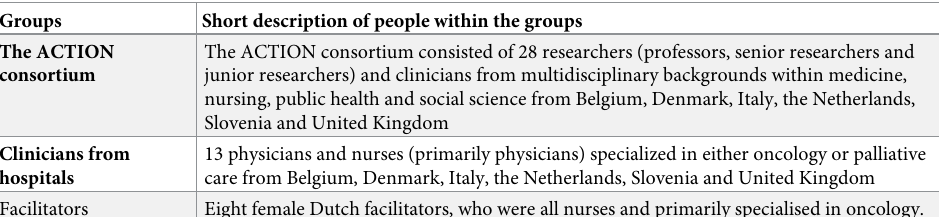
Table 2. Overview of the groups of people who contributed to the development of the My Preferences Form (MPF). Groups